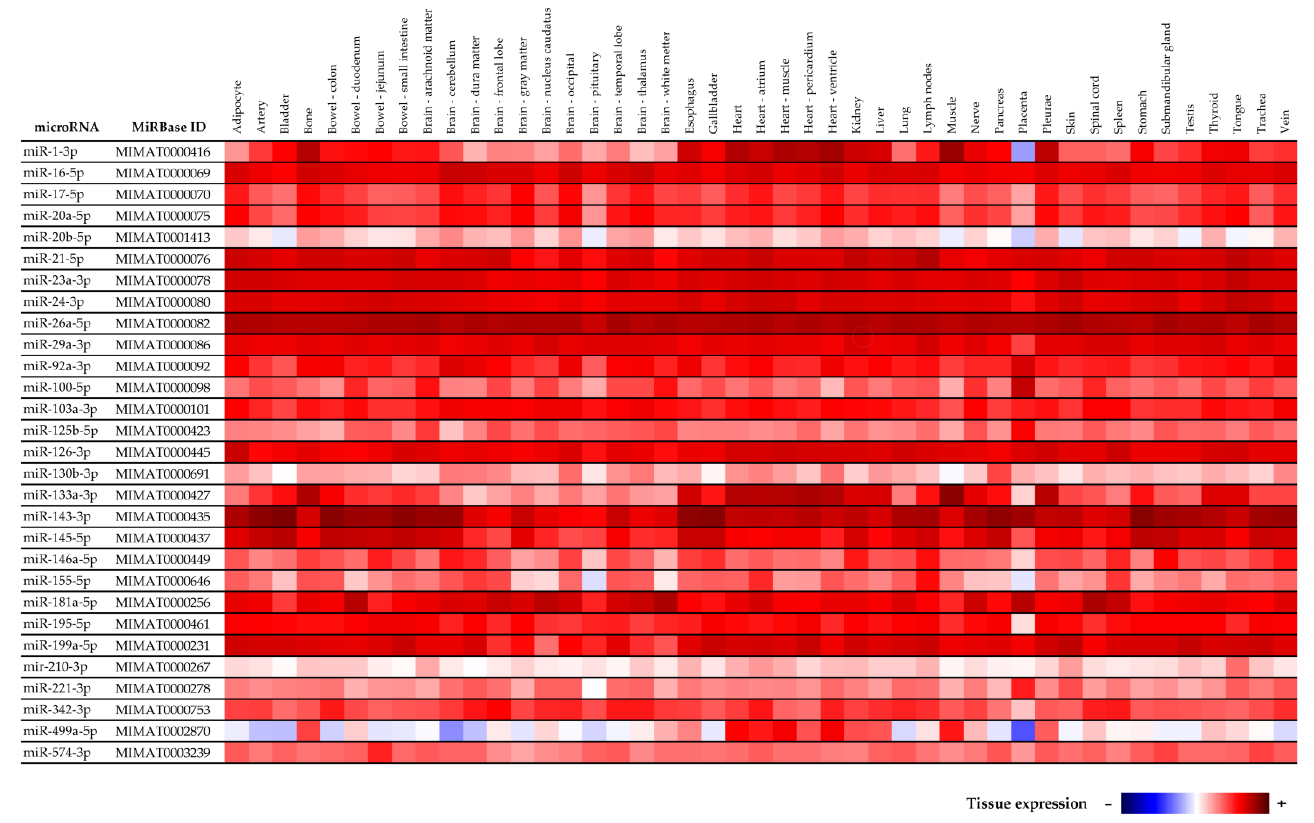
Figure 7. Tissue specificity of cardiovascular disease associated microRNAs according to MirG- eneDB 2.1 (mirgenedb.org, accessed on 15 February 2022, Tromso Research Foundation). 2.1 (mirgenedb.org, accessed on 15 February 2022, Tromso Research